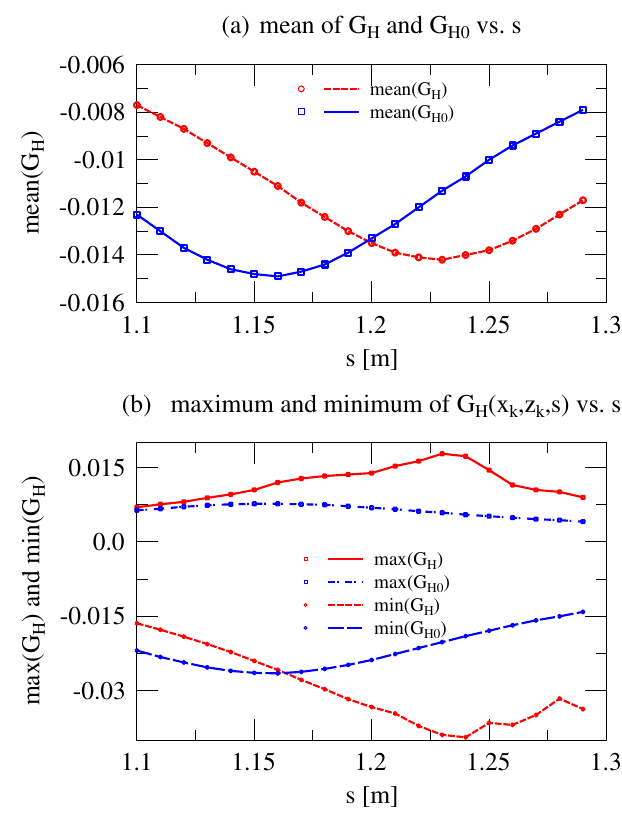
(cid:1) 1 mm - mrad and nx 0 (cid:3) ~ x (cid:3) ~ z ; ~ z ; s (cid:5) and G ; s (cid:5) for the H k k H 0 k (cid:3) ~ z ; s (cid:5) for the representative particles vs H 0 k